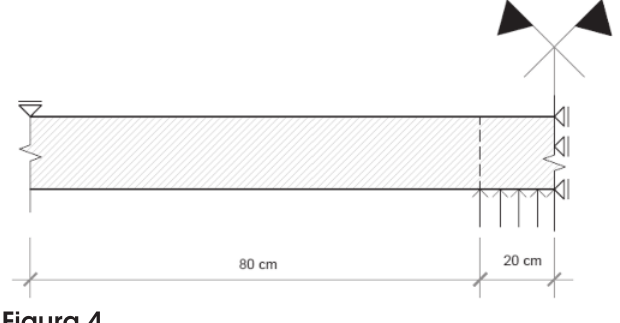
Condições de contorno da região da laje estudada